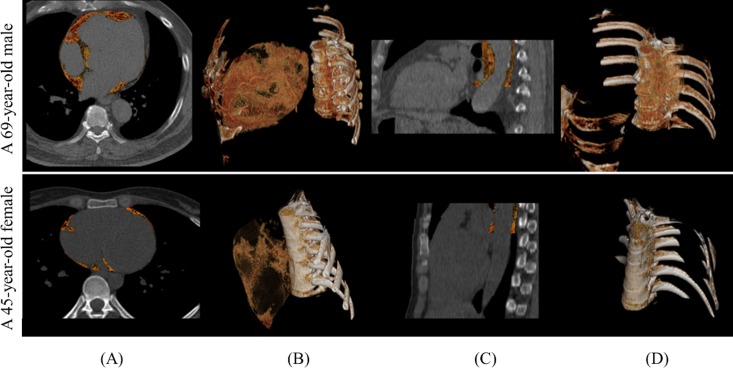
Examples of PCF (A, B) and TAT (C, D) in 2D and 3D computed tomography views. A 69-year-old male with large amounts of PCF (235.8ml), TAT (24.9ml) and the lab data (WBC: 10700/mm3, Neutrophil: 9502/mm3, NLR: 15.05, monocyte: 481/mm3) (First row). A 45-year-old female with small amounts of PCF (18.7ml), TAT (1.24ml) and the lab data (WBC: 3900/mm3, Neutrophil: 2211/mm3, NLR: 1.702, monocyte: 238/mm3) (Second row). PCF: peri-cardial adipose tissue; TAT: thoracic peri-aortic adipose tissue; WBC: white blood cell count; NLR: neutrophil-to-lymphocyte ratio.